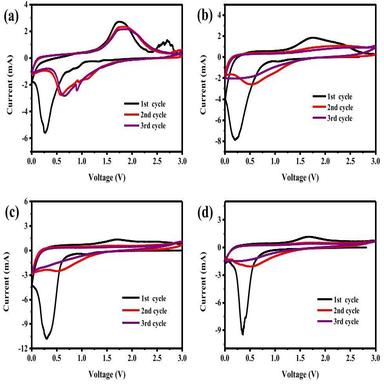
CV curves of (a) pure Fe3O4, (b) Fe3O4@CTP QDs-1, (c) Fe3O4@CTP QDs-2 and (d) Fe3O4@CTP QDs-3 composite electrodes.